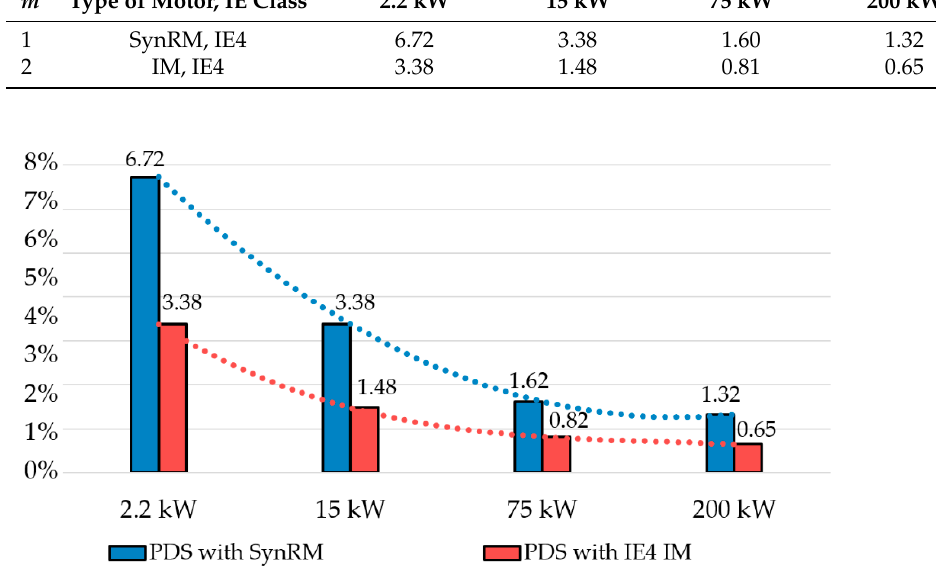
Figure 6. Cost savings/avoided CO 2 emissions (in %) for an output power range of 2.2–200 kW relative to the PDS with an IE3 motor. Table 8. Cost savings (avoided CO 2 emissions, in%) relative to the PDS with an IE3 motor.